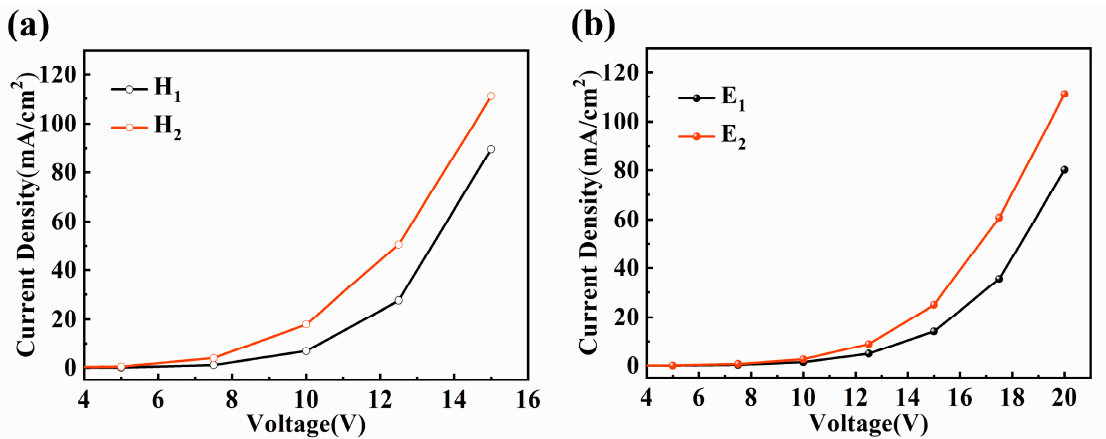
Figure 4. Current density–voltage curves of ( a ) hole-only devices H 1 –H 2 and ( b ) electron-only devices E 1 –E 2 .